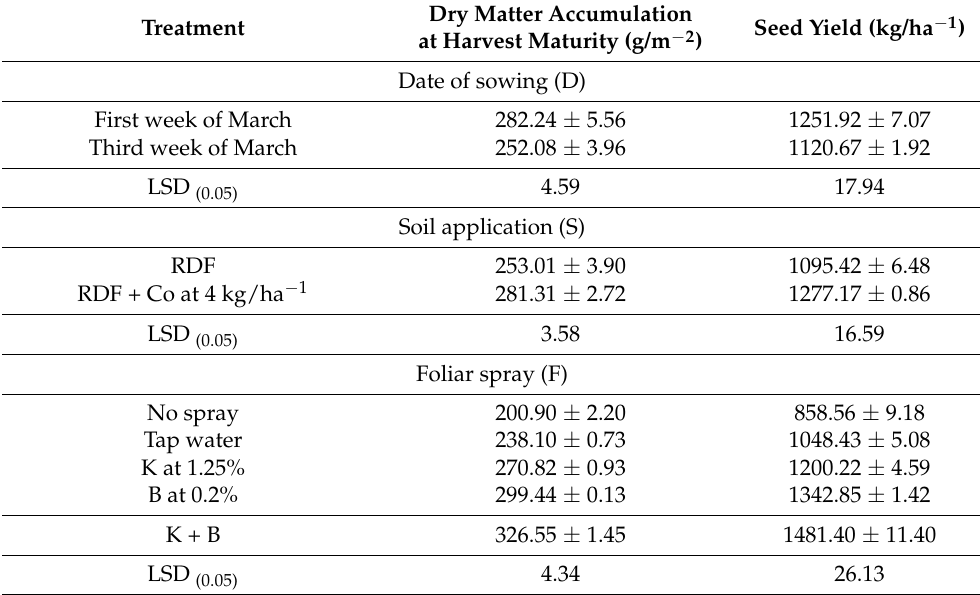
Table 11. Factor-wise effect of the date of sowing, soil application of Co, and foliar spray with K and B on the final dry matter accumulation and seed yield of black gram (pooled over two years) during the spring-summer